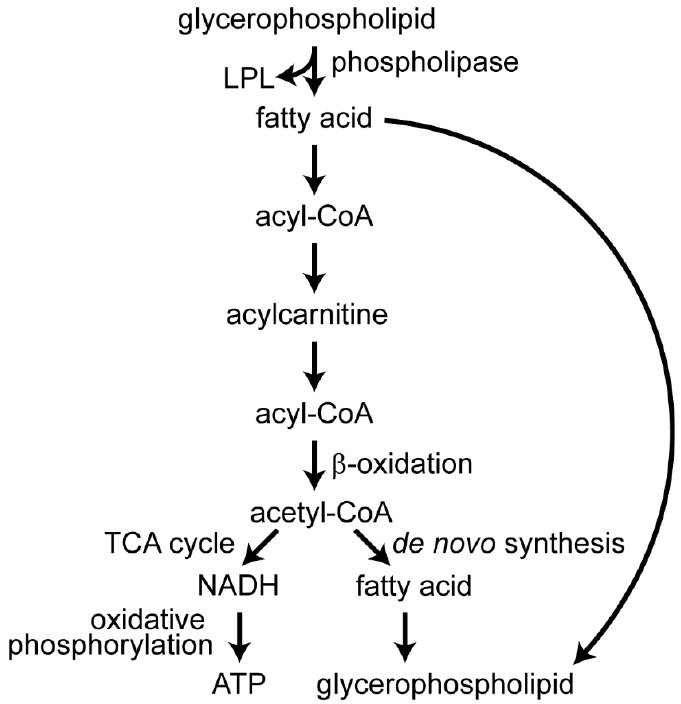
Figure 3. Fatty acid metabolism. Fatty acids are freed from glycerophospholipids by